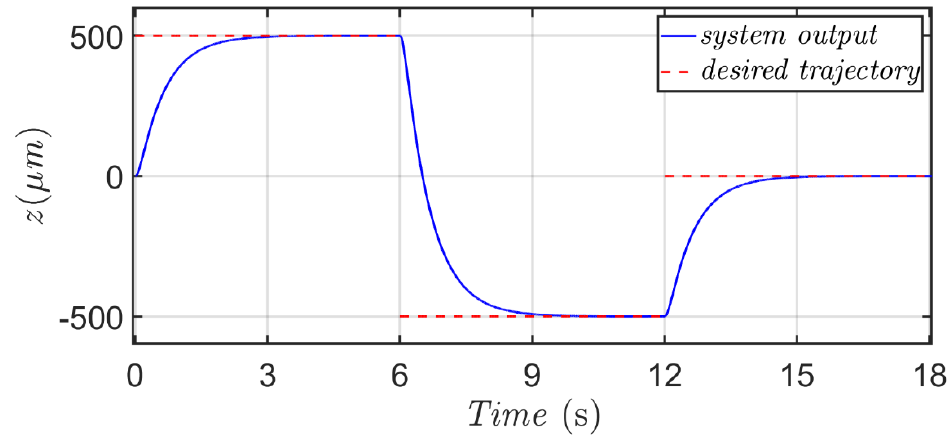
Figure 15. History of the proposed micro-positioning actuator for a desired stair-type trajectory.